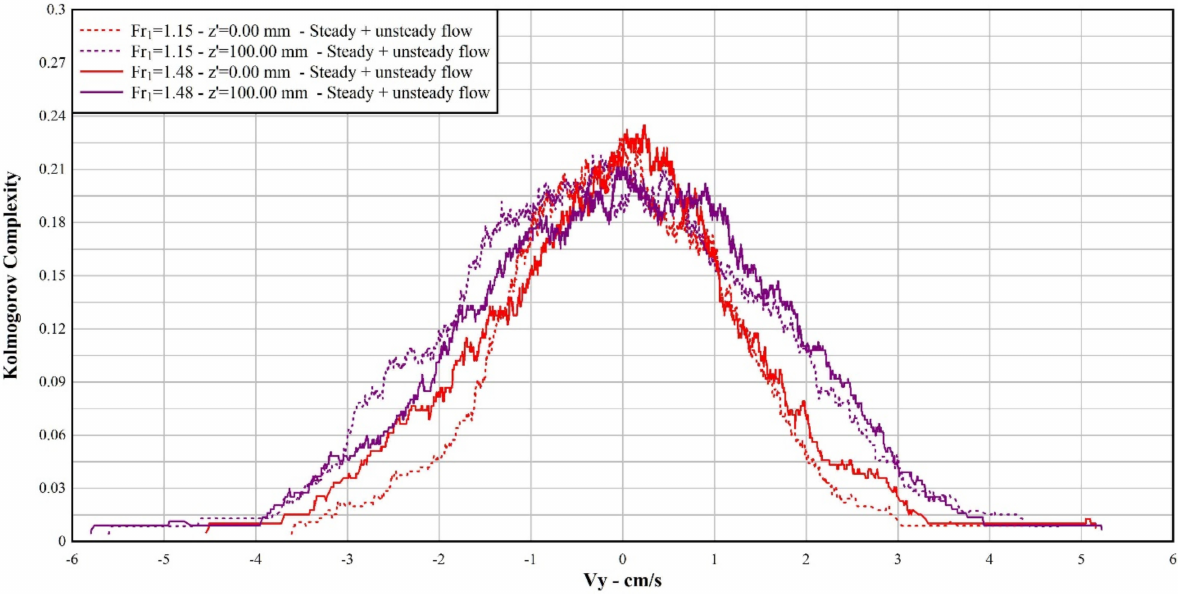
Figure 11. Undular surge, Run 60-7 and breaking surge Run 60-6. Kolmogorov complexity spectra for V y at z (cid:48) = 0.00 mm and 100